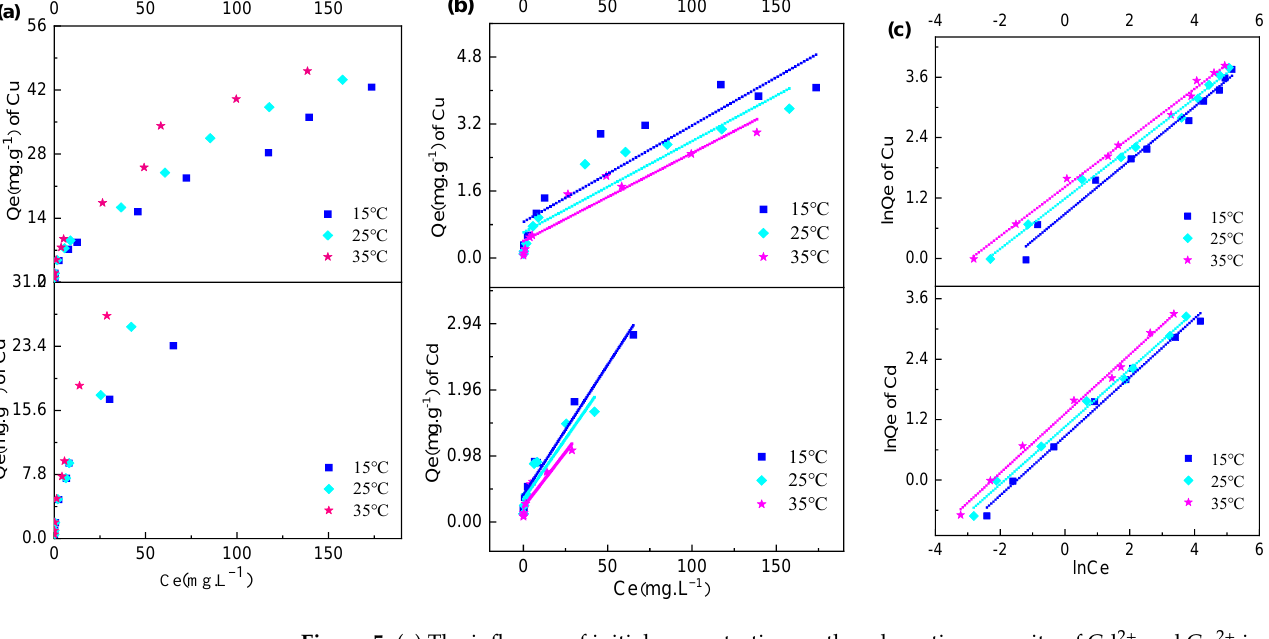
Figure 5. ( a ) The influence of initial concentration on the adsorption capacity of Cd 2+ and Cu 2+ ions of BHW; ( b ) the linear fitting of the Langmuir model; ( c ) the linear fitting of the Freundlich model . Figure 5b and Figure 5c are respectively the linear fitting diagrams of the Freundlich